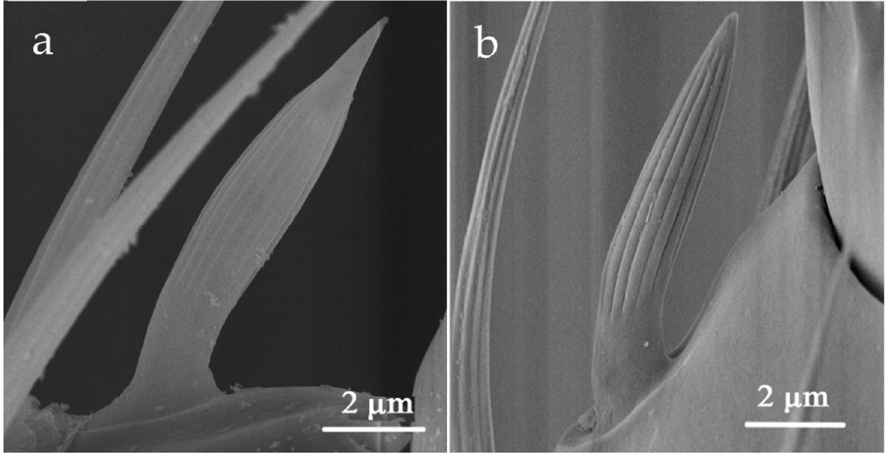
Figure 6. Sensilla coeloconica (SCo) on the flagellum III in O. loti ( a ) and S. kaszabi ( b ).